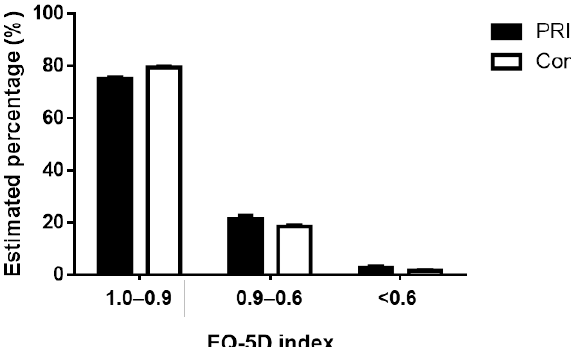
Figure 1. Distribution according to the degree of decline in health-related quality of life. Abbreviations: PRISm, preserved ratio impaired spirometry; EQ-5D, Euro Quality of Life-5D. More participants with PRISm experienced sputum symptoms (PRISm 10.9% vs. control Table 2. Factors associated with health-related quality of life in the preserved ratio impaired spirometry (PRISm)